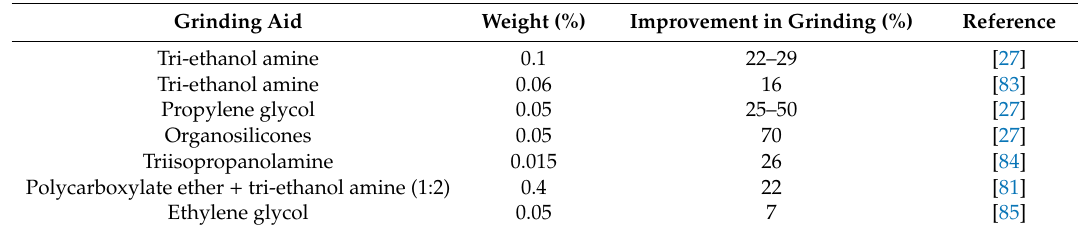
Figure 10. ( a ) Energy distribution in cement production equipment (data source: [82]). ( b ) Schematic of dry cement production (modified after [82]). Table 6. Improvement in grindability of cement clinker using grinding